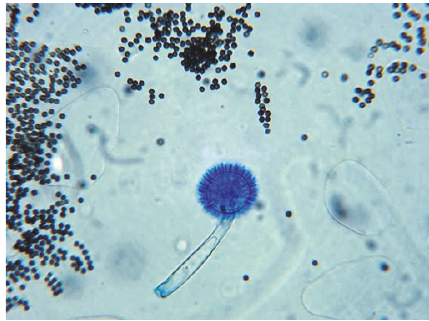
Figure 6: Aspergillus niger